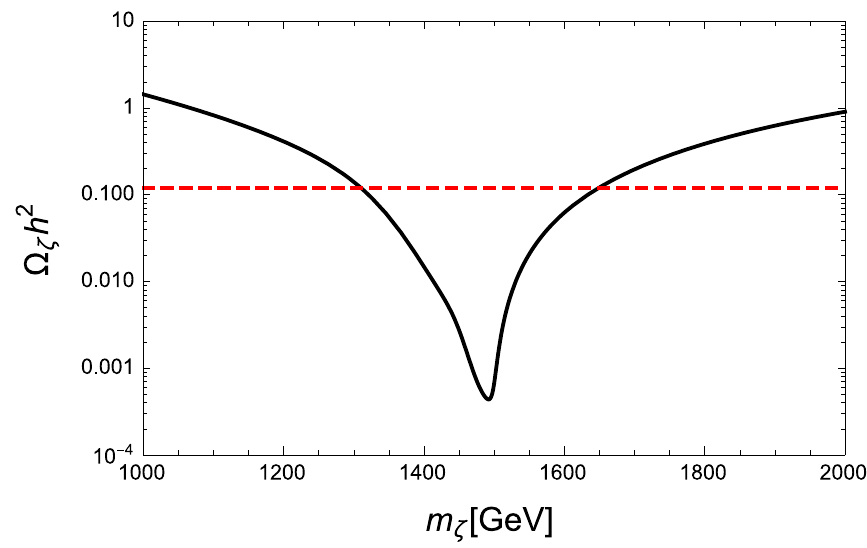
Figure 2 . A sample plot of DM relic density vs. m ζ for g ζ = ˜ g BL = 0 . 2 and M X = 3 TeV, along with the observed relic density (dashed horizontal line).